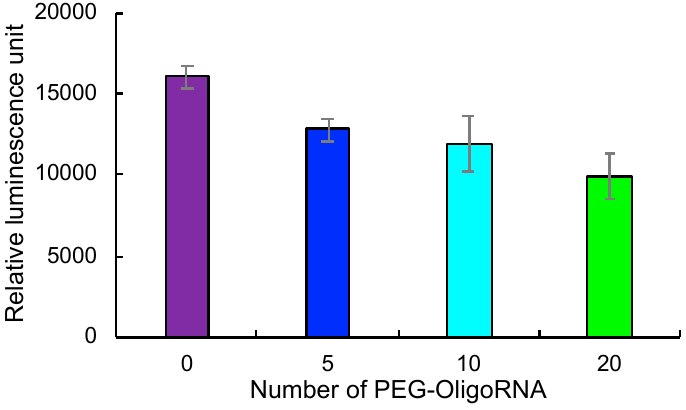
Figure 2. Translation efficiency from mRNA in cell free system. GLuc mRNA hybridized with PEG-OligoRNAs was incubated in rabbit reticulocyte lysate. After 4 h of incubation, GLuc protein expression levels were measured. n = 3. Data are presented as mean ± standard error of the mean.